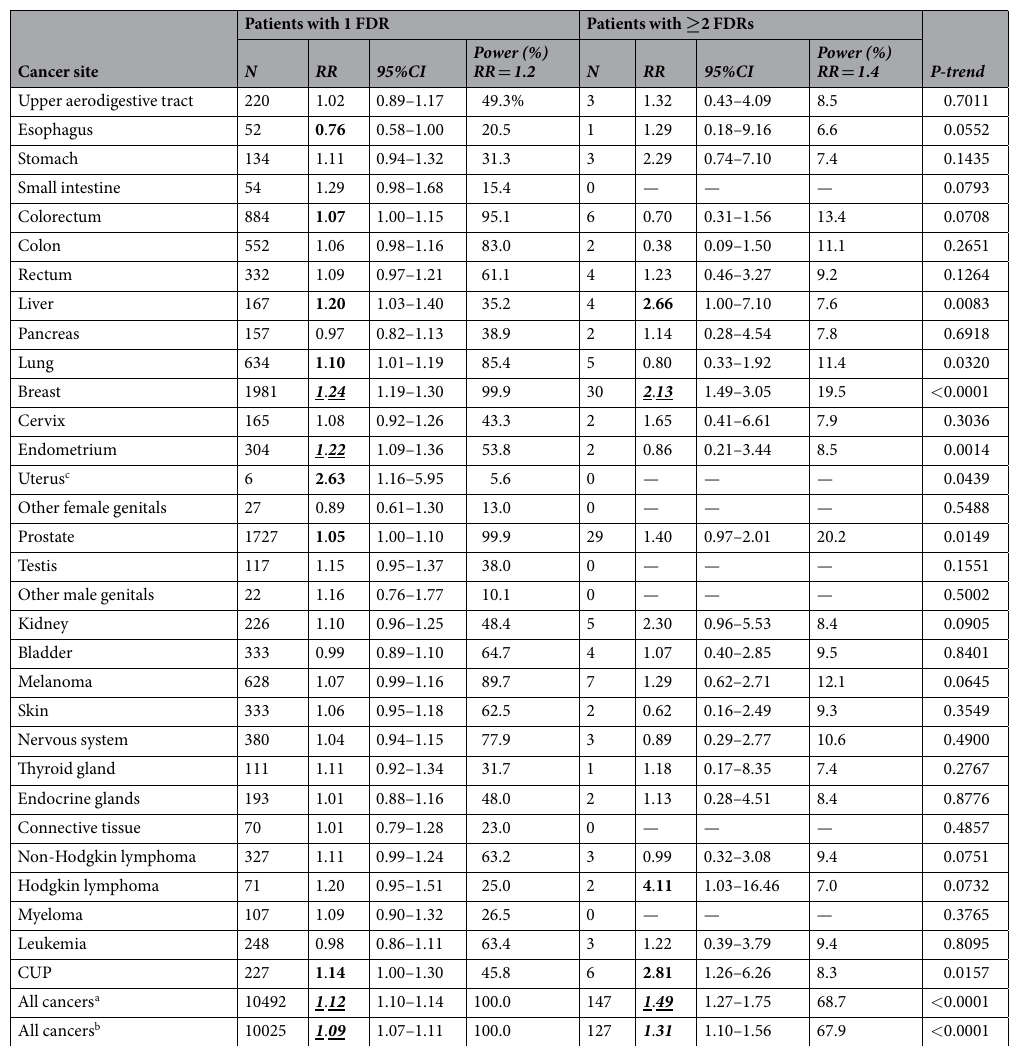
Table 3. Other cancer risk when first-degree relatives were diagnosed with invasive ovarian cancer. FDR: first- degree relative; CUP: cancer of unknown primary. Bolding, italic and underlining indicate that the 95% CI, 99% CI and 99.9% CI did not overlap with 1.00 respectively. a all cancers include ovarian cancers and all other cancers. b all cancers include all other cancers except ovarian cancer. c cancer of other parts of uterus, including